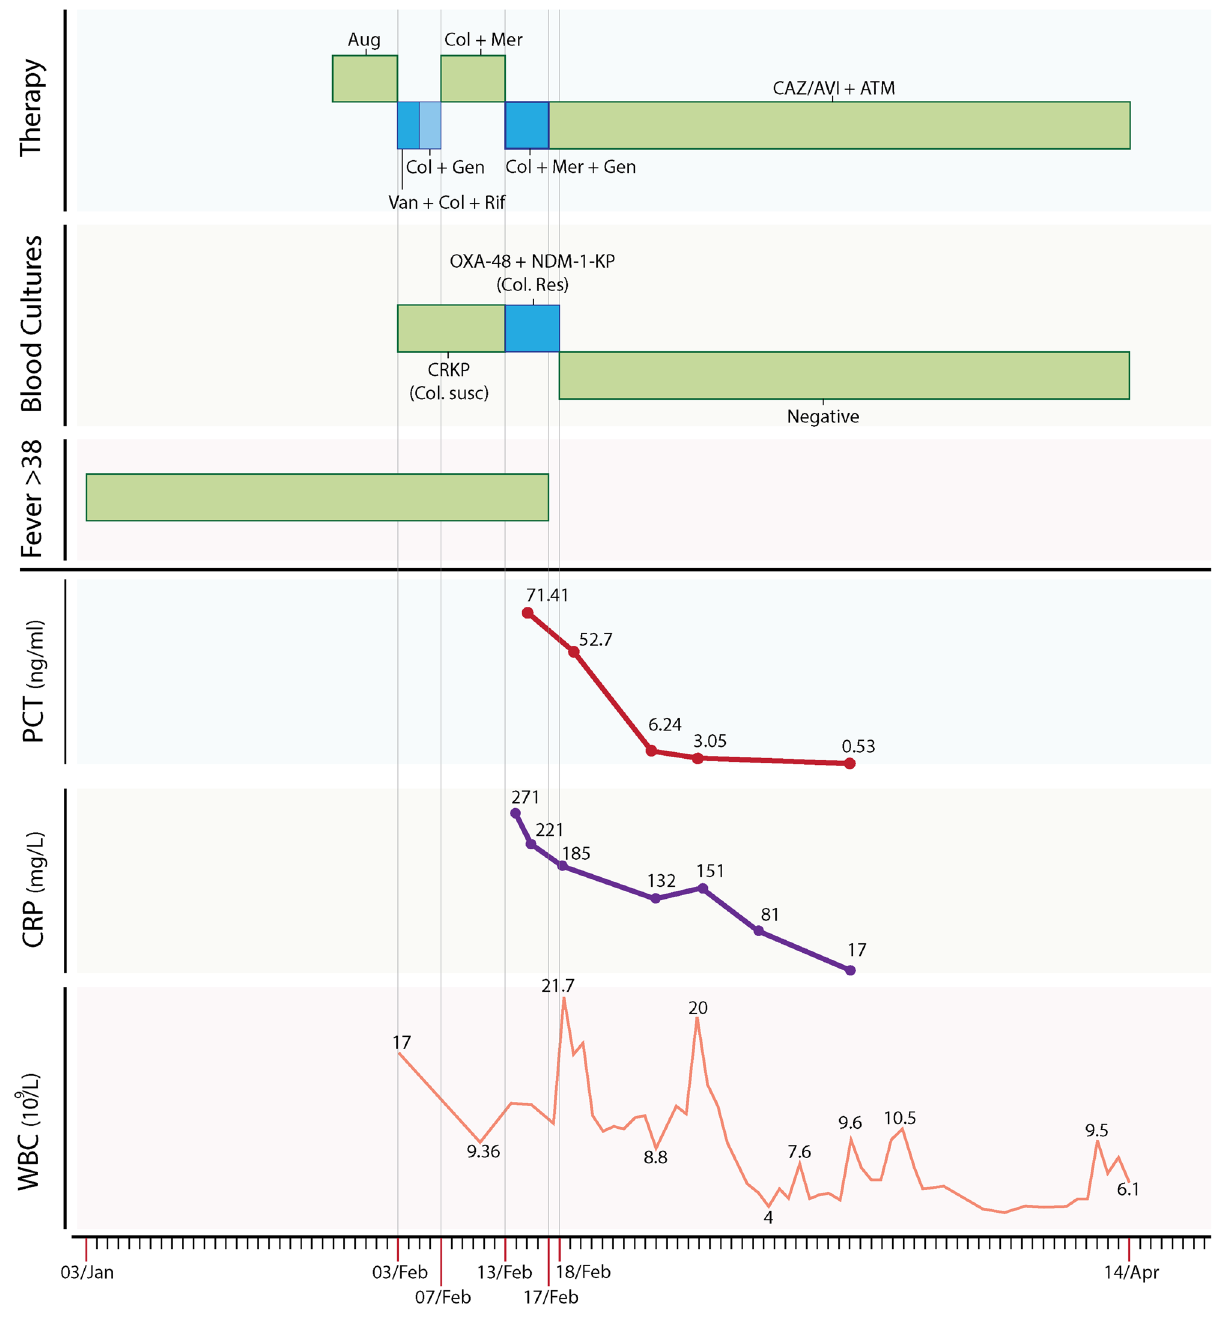
Figure 1. Patient timeline for antimicrobial exposure, fever pattern, duration of persistence of infection in blood cultures with trends of important laboratory investigations. Important dates marked from left to right at the bottom represented the start of symptoms (03/Jan), first hospital admission (03/Feb), transfer to the second hospital (07/Feb), transfer to our cardiac centre (13/Feb), the start of the therapy CAZ/AVI plus ATM combination (17/Feb), date of the first negative culture (18/Feb) and date of discharge from hospital (14/ Apr). Aug augmentin, Van vancomycin, Col colistin, Rif rifampicin, Gen gentamicin, Mer meropenem, CAZ/ AVI ceftazidime/avibactam, ATM aztreonam, CRKP carbapenem-resistant Klebsiella pneumoniae , OXA-48 oxacillinase, NDM New Delhi Metallo-β-lactamase, Susc susceptible; Res resistant; PCT procalcitonin; CRP C-reactive protein; WBC white blood